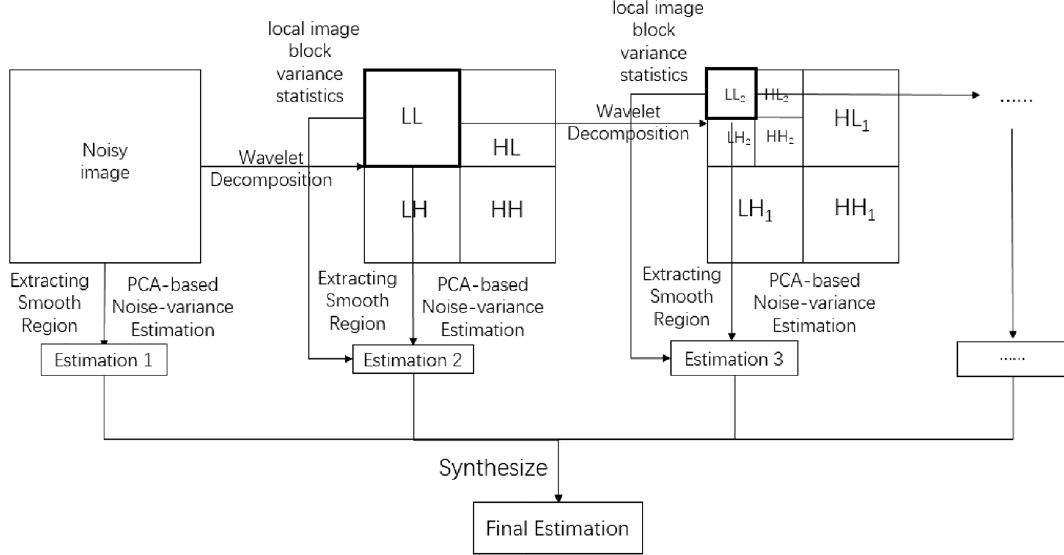
Figure 3. Flow chart of the improved PCA-based noise variance estimation